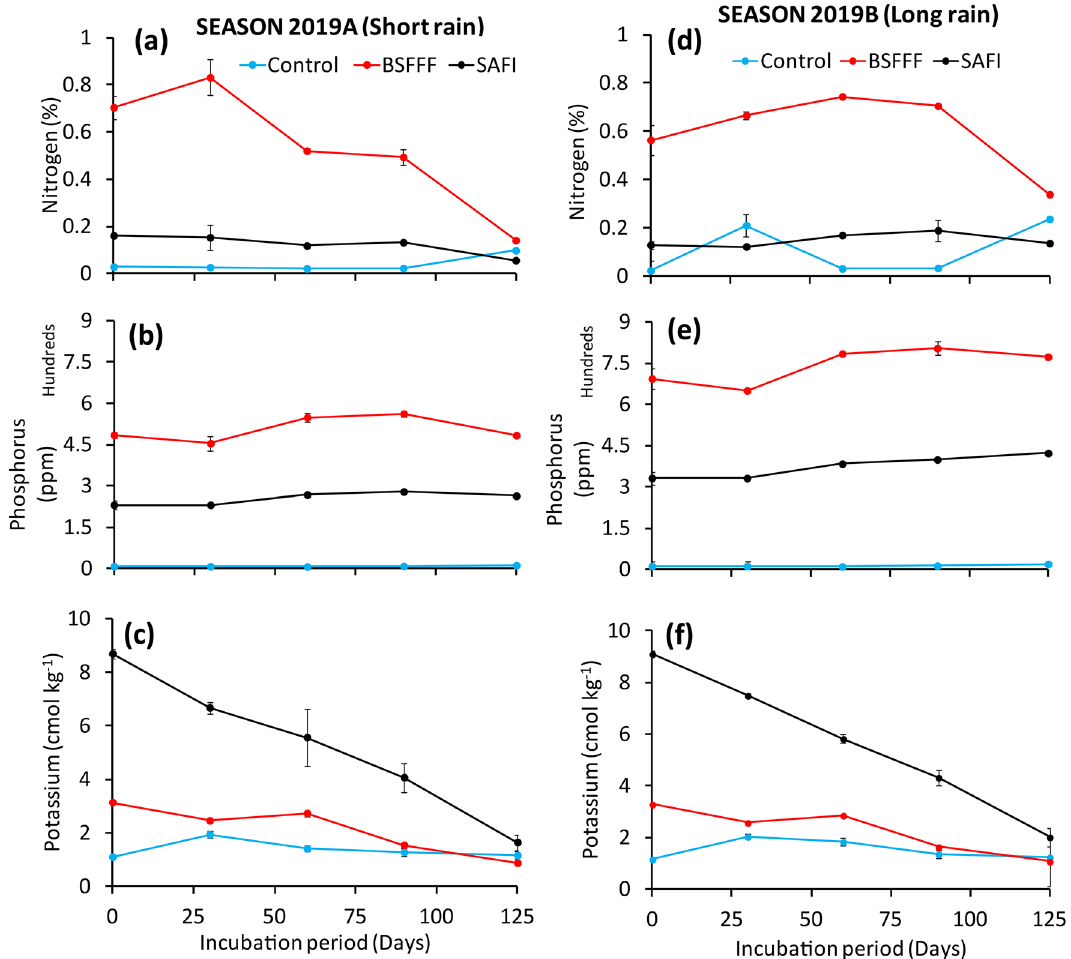
Figure 2. Effects of different fertilizers on concentrations of total nitrogen ( a , d ), available phosphorus ( b , e ) and exchangeable potassium ( c , f ) of soils during the short ( a – c ) and long rainy ( d – f ) seasons incubation